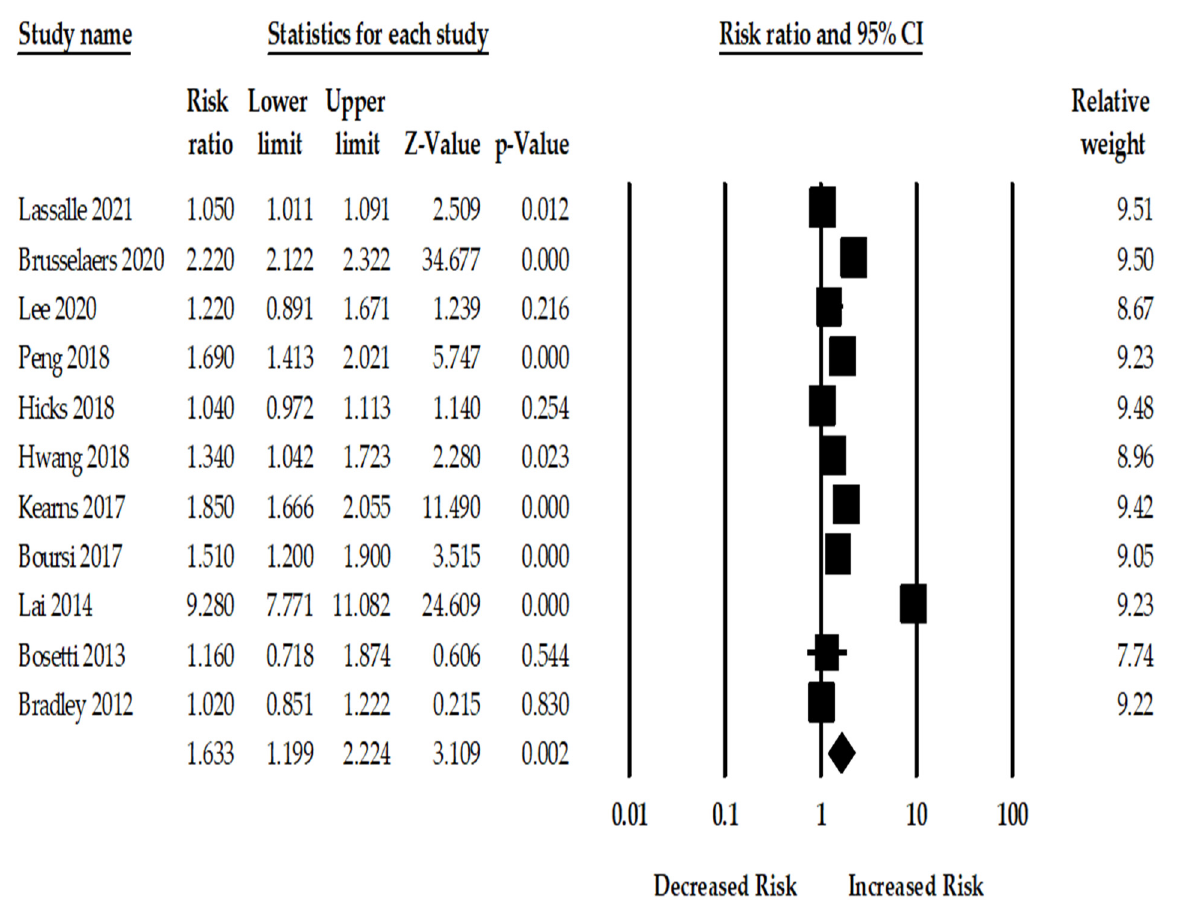
Table 1. Subgroup analysis of all studies.